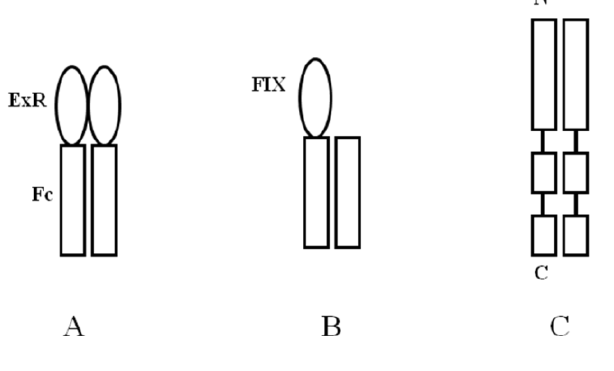
Figure 4. Illustration of various Fc-fusion proteins: ( A ) construct of extracellular domain of receptors (ExR) fused to the N-terminus of Fc, ( B ) FIX (coagulation factor IX)—Fc monomer comprising one functional FIX and two Fc domains, and ( C ) Fc fusion of the peptide, romiplostin/Nplate®, that contains two tandem repeats of the peptide. Fc is depicted as long rectangles and the peptide as short rectangles. These three constructs form dimers through the Fc